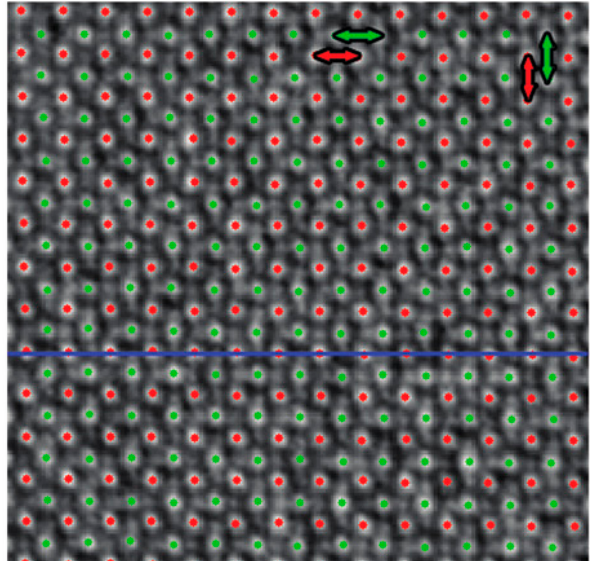
Figure 1. Image of a twin wall in CaTiO 3 with polar shifts of Ti positions inside the wall and two adjacent layers of Ti shifts towards the wall center [17].